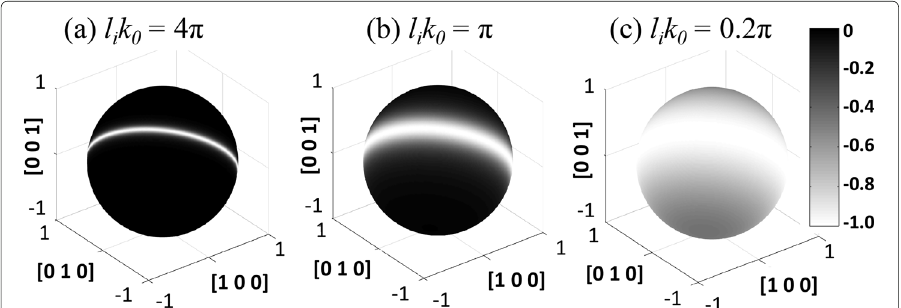
Fig. 1 (Color online) Normalized change in recombination ( σ k λ ) caused by perturbation waves with 1D SIA diffusion along the [1 1 1] direction in a bcc crystal. The wavelength used in the calculation is a 0.5, b 2.0, and c 10.0 of SIA mean free life, l